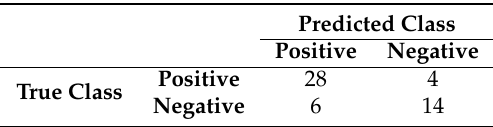
Table 6. Percentage of hits and misses in the forecasts (red alert).